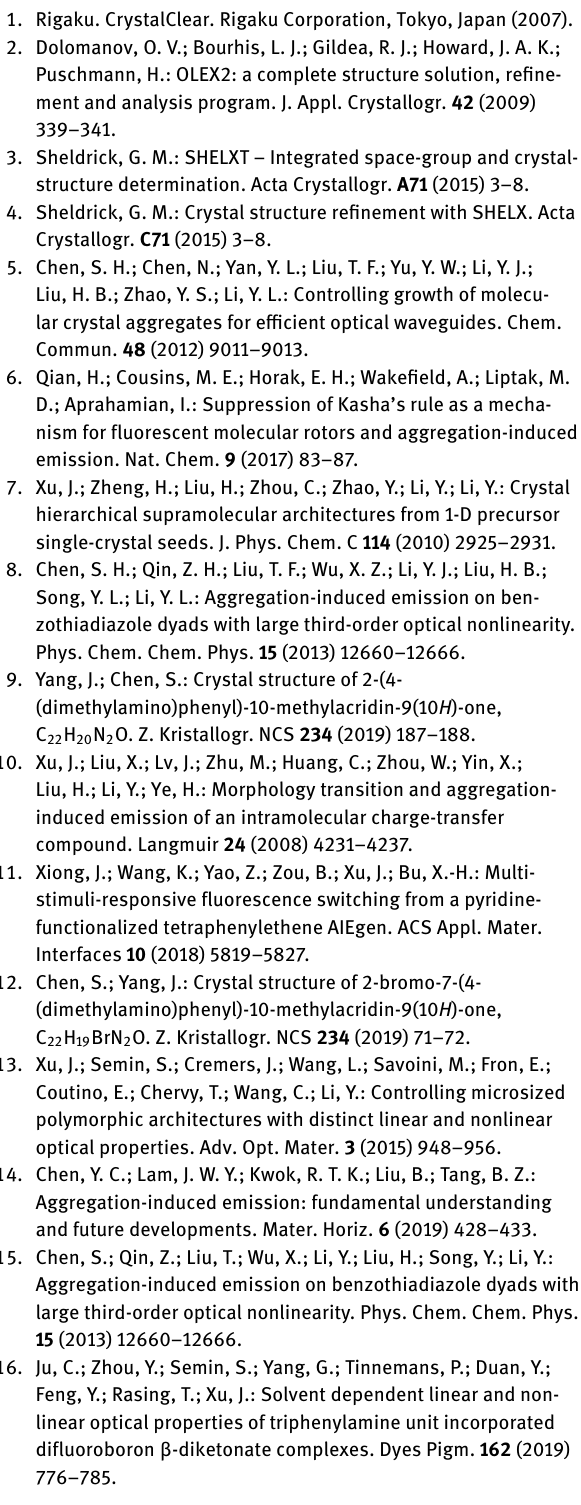
Table 2: Fractional atomic coordinates and isotropic or equivalent isotropic displacement parameters (Å 2